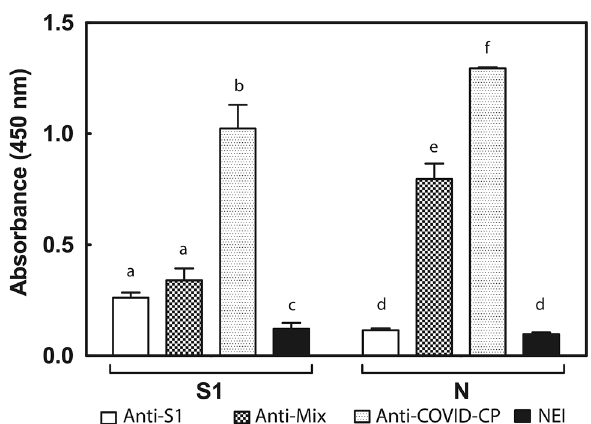
Figure 6. Anti-SARS-CoV-2 equine IgG-mediated activation of human FcγRs. 1: anti-S1 formulation; 2: anti- Mix formulation; 3: anti-SARS-CoV-2 human convalescent plasma pool; 4: Normal equine immunoglobulin preparation (NEI). Plates were coated with 1 µg/well of N and S1 proteins and were incubated with 20 mg/ dL of immunoglobulin preparations. BW:FcγRIIIA-ζ transfectants (BW5147 thymoma cells expressing the extracellular portion of human FcγR FcγRIIIA fused to the mouse CD3 ζ–chain) were used. Absorbance was recorded at 450 nm and corresponds to the measurement of mIL-2 by ELISA. Experiments were performed in triplicate and expressed as mean ± SD. A comparison was made between groups by immunogen. Letters indicate statistically significant differences ( P <